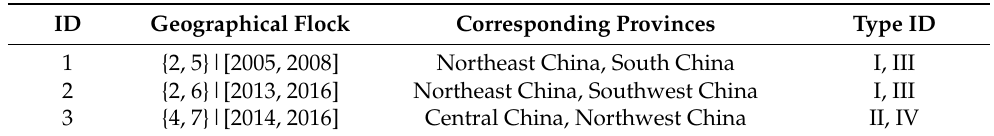
Table 6. The discovered geographical flock patterns based on the criterion of the extreme number- duration values on the geographical region level.